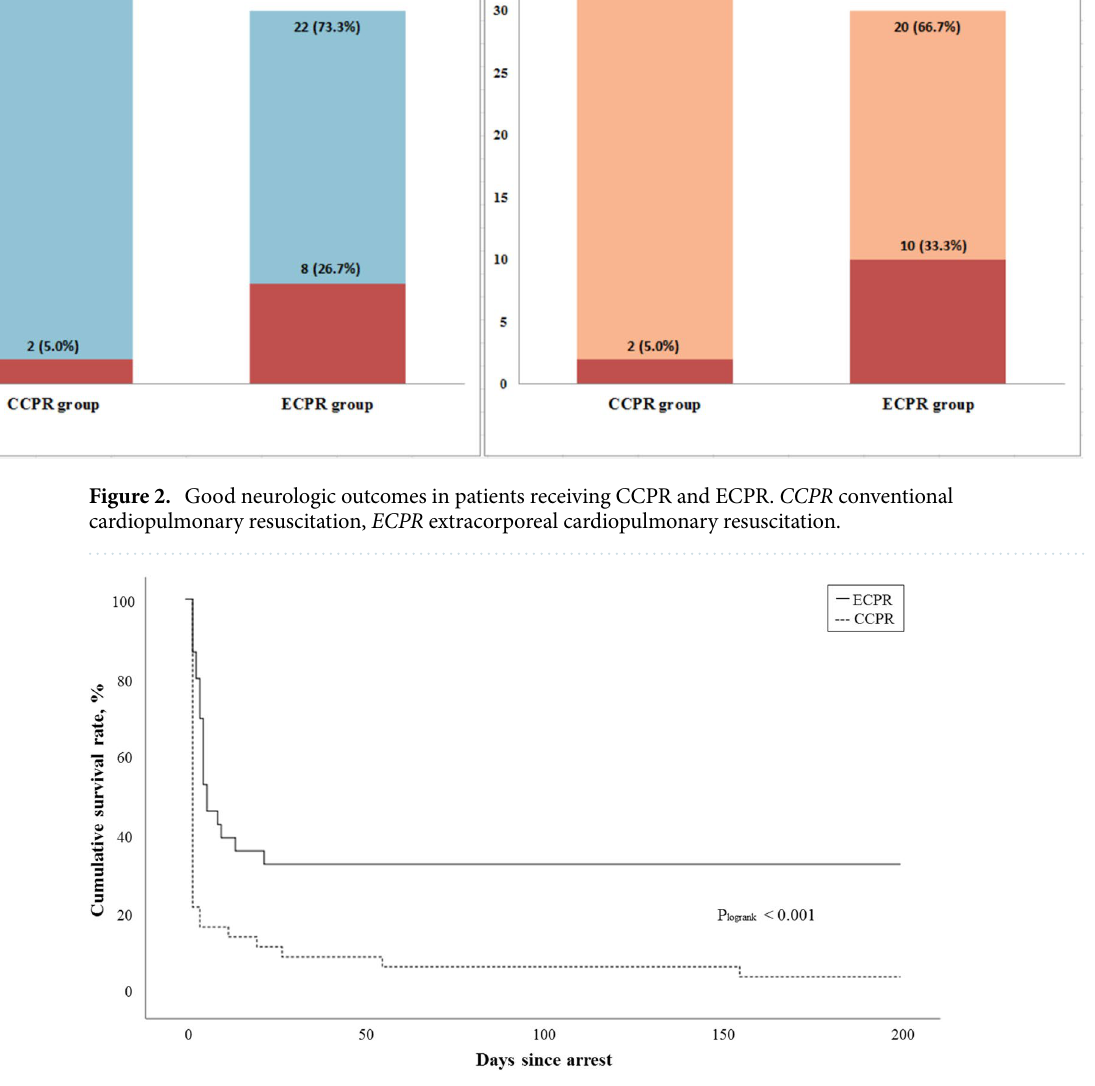
Figure 3. Survival rates in patients receiving CCPR and ECPR. CCPR conventional cardiopulmonary resuscitation, ECPR extracorporeal cardiopulmonary